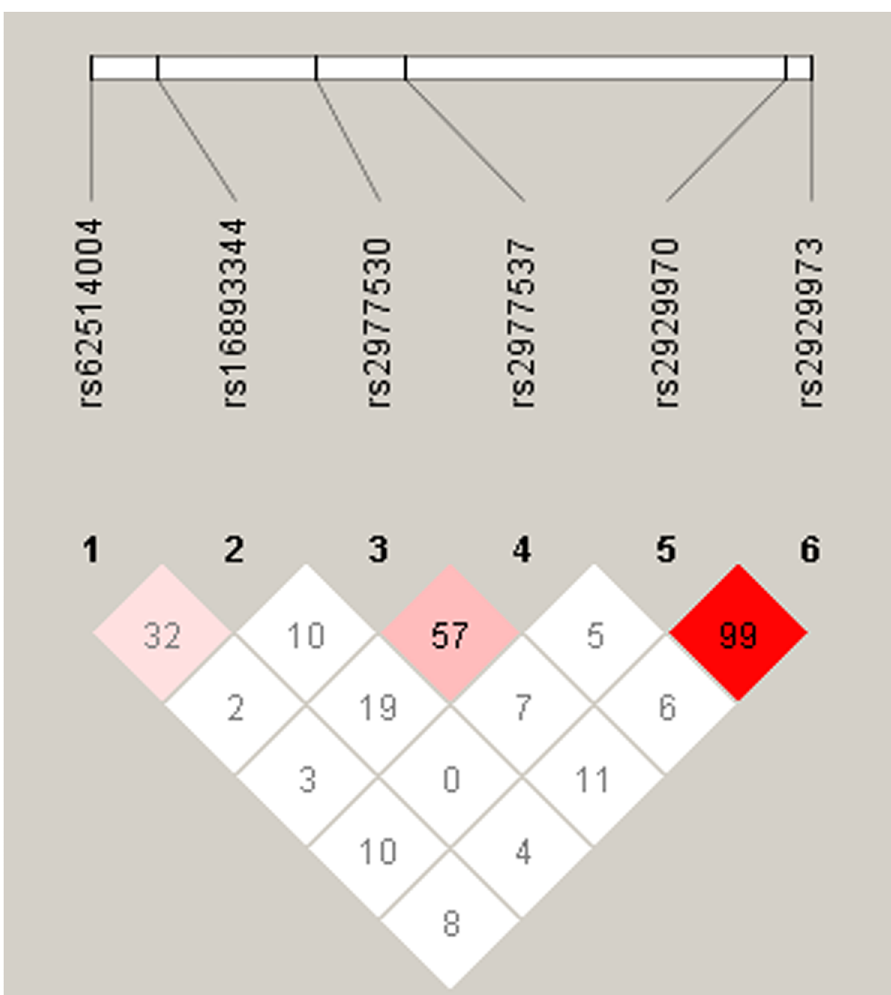
Fig 1. The pairwise linkage disequilibrium patterns of WISP1 gene. Block is pairwise D ’ plots and haplotype blocks obtained from HAPLOVIEW.